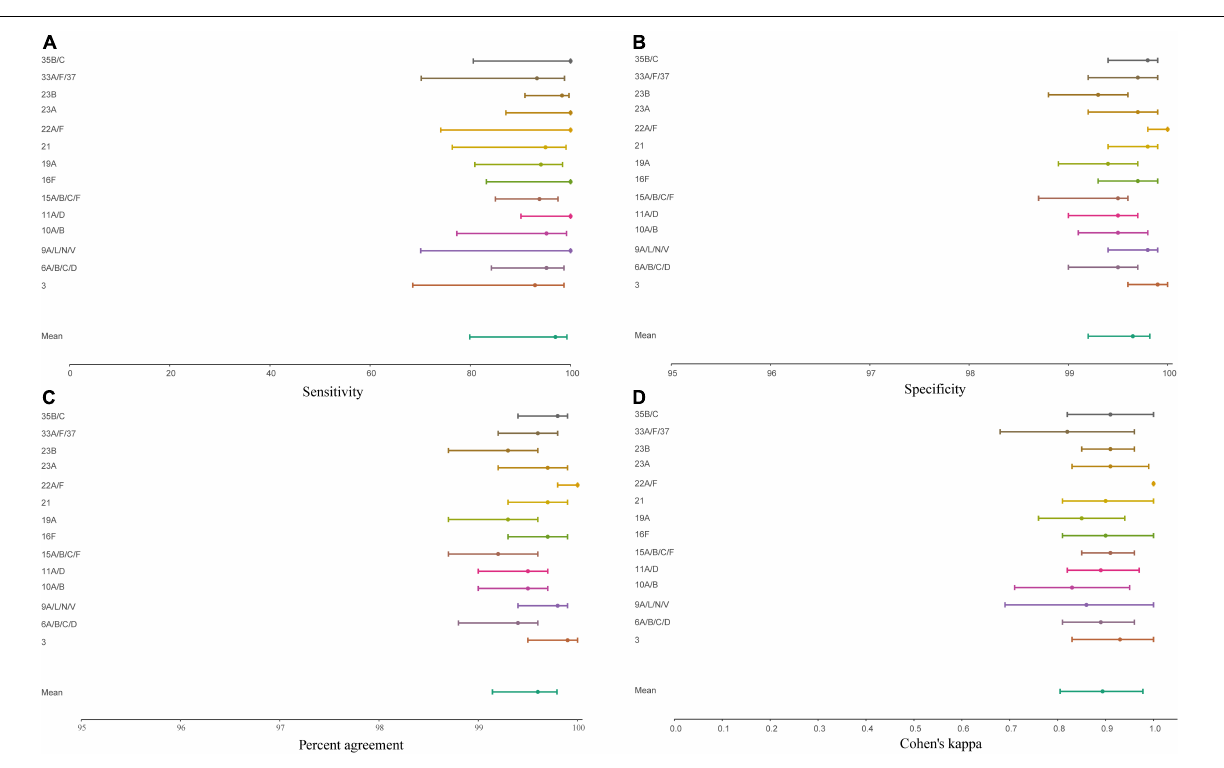
FIGURE 4 | Scatter plots (A–C) displaying correlation between cycle threshold (C q ) from real-time PCR (qPCR) assays targeting the Streptococcus pneumoniae piaB and serotype/serogroup specific signal detected with qPCR for nasopharyngeal samples classified positive for S. pneumoniae according to ROCd C q criterium (green dashed lines). Bland-Altman plot (D) displaying agreement between piaB and dominant serotype detected by qPCR. Each dot represents an individual serotype carriage event detected by qPCR in culture-enriched nasopharyngeal sample (A–C) . Dots in (A) depicts serotypes detected with qPCR. Dots are color-coded according to serotypes/serogroup targeted in an assay (see legend). Color dots in (B) depict subdominant serotypes detected qPCR while gray dots mark dominant serotypes. Red dots in (A,B) depict samples not generating any signal in serotype/serogroup-specific qPCRs or with the signal of C q higher than the ROCd C q threshold, hence classified as negative for a serotype. In (C,D) green dots mark samples with congruent serotype between culture and molecular methods and orange dots mark samples with non-congruent result. In (D) shaded gray areas mark the 95% confidence interval of the upper limit of agreement, bias and lower limit of agreement. The continuous line marks the line of equality.